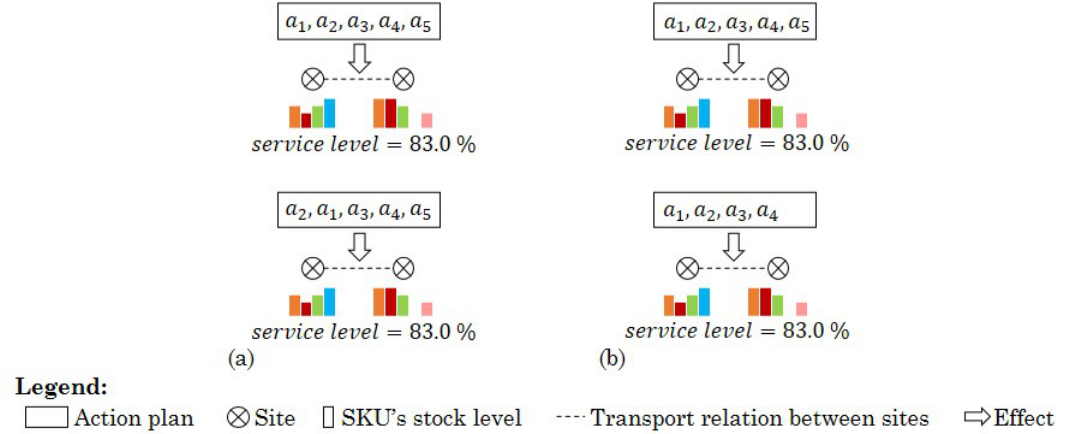
Figure 8. Equivalent action plans: ( a ) action plans with interchangeable actions and ( b ) action plans with redundant